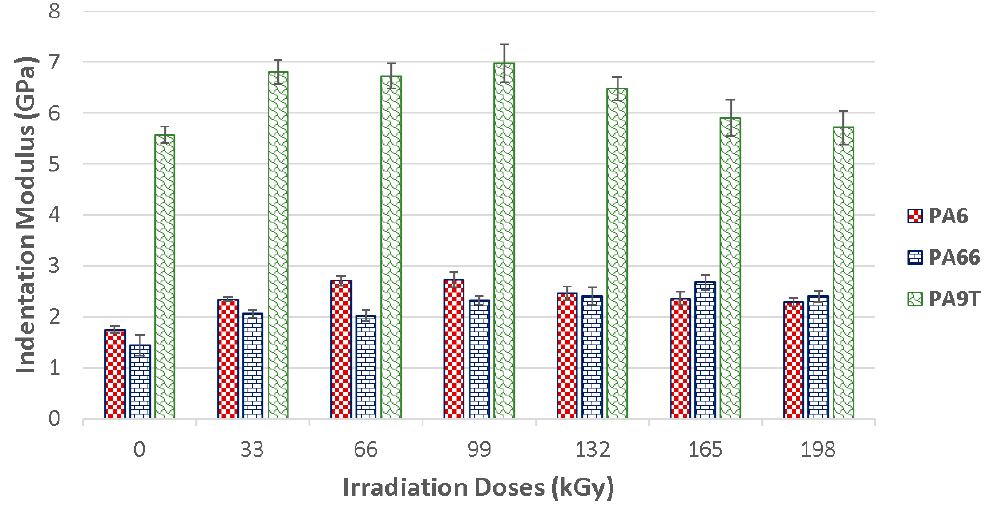
Figure 8. Indentation modulus (E IT ) of irradiated PA 6, PA 66 and PA